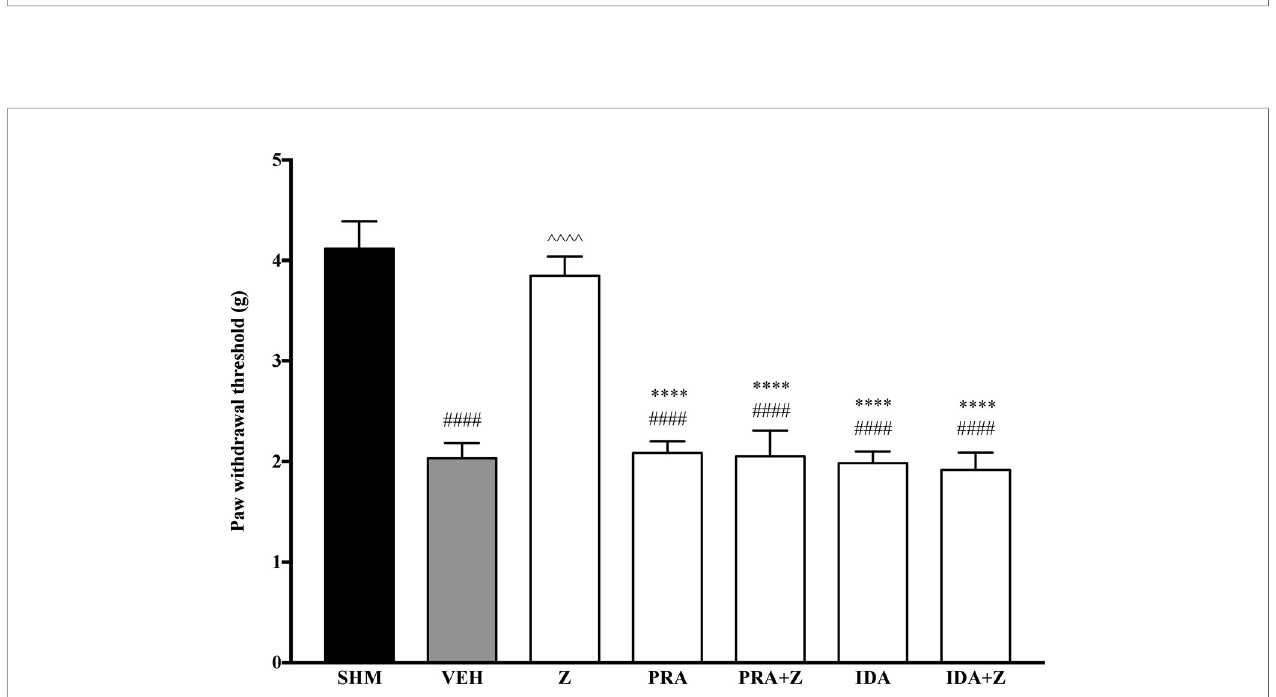
FIGURE 3 | Effect of prazosin ( a 1 -adrenoceptor antagonist) and idazoxan ( a 2 -adrenoceptor antagonist) pre-treatment on zerumbone against mechanical allodynia in CCI-induced neuropathic pain mice. Data are presented as mean ± SEM (n = 6). #### p < 0.0001 as compared to sham, ^^^^ p < 0.0001 as compared to vehicle and **** p < 0.0001 as compared to zerumbone-treated group. SHM (Sham); VEH (Vehicle, 10 mL/kg i.p.); Z (Zerumbone, 10 mg/kg i.p.); PRA (Prazosin, 10 mg/kg i.p.); IDA (Idazoxan, 2 mg/kg i.p.).